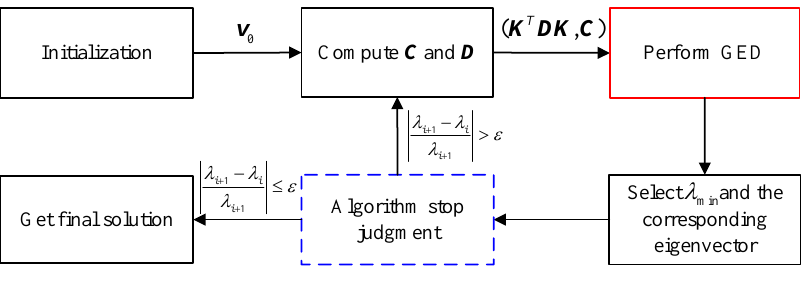
Figure 2. The flowchart of the IGED algorithm.